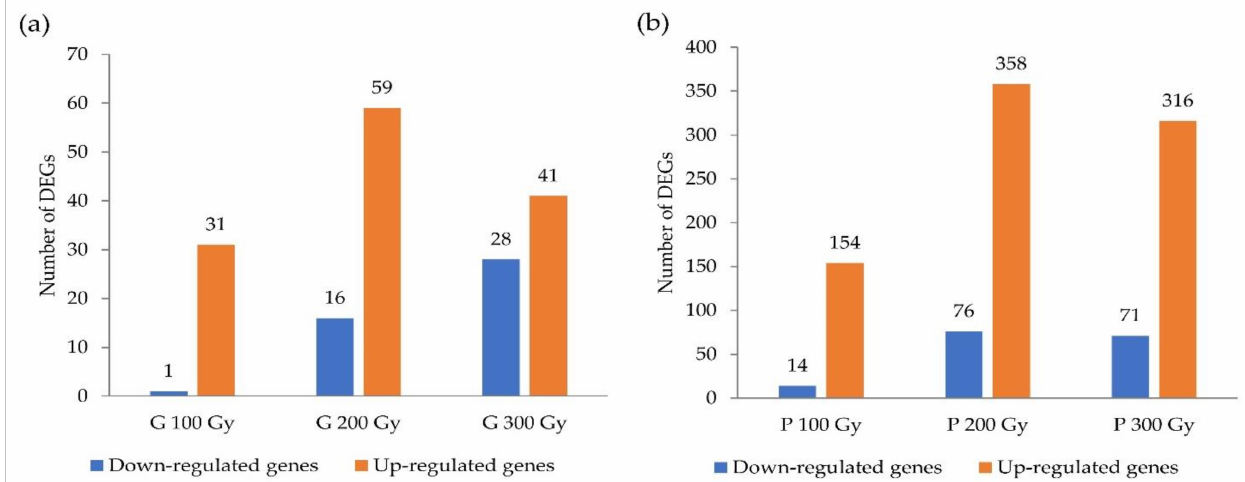
Figure 1. Number of differentially expressed genes (DEGs) that were identified with a comparison between the treatments and control in cowpeas. ( a ) Gamma-ray treatments, ( b ) Proton-beam